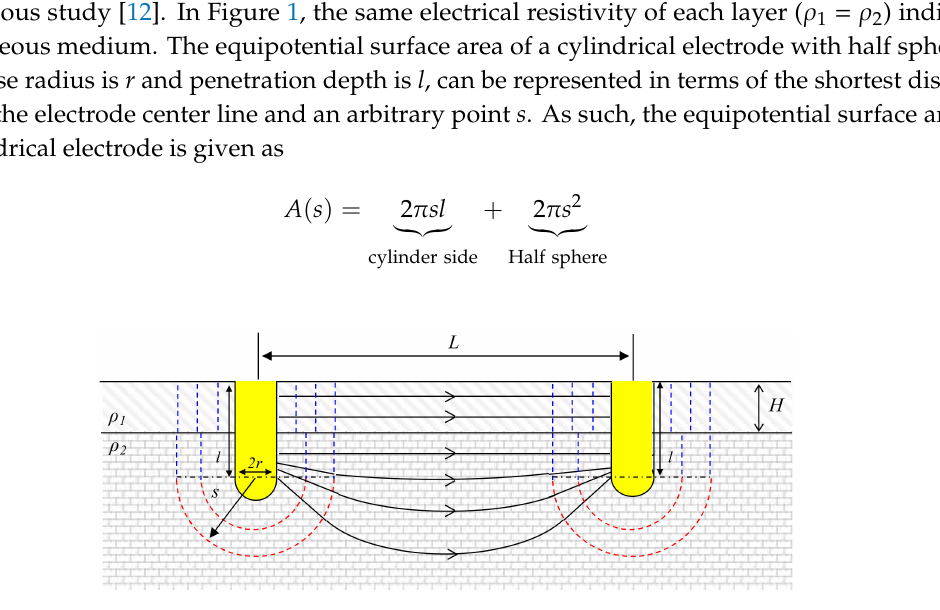
Figure 1. Definitions of the symbols used to represent two fully penetrated cylindrical electrodes embedded on two layers ( H < l ). ρ 1 is greater than ρ 2